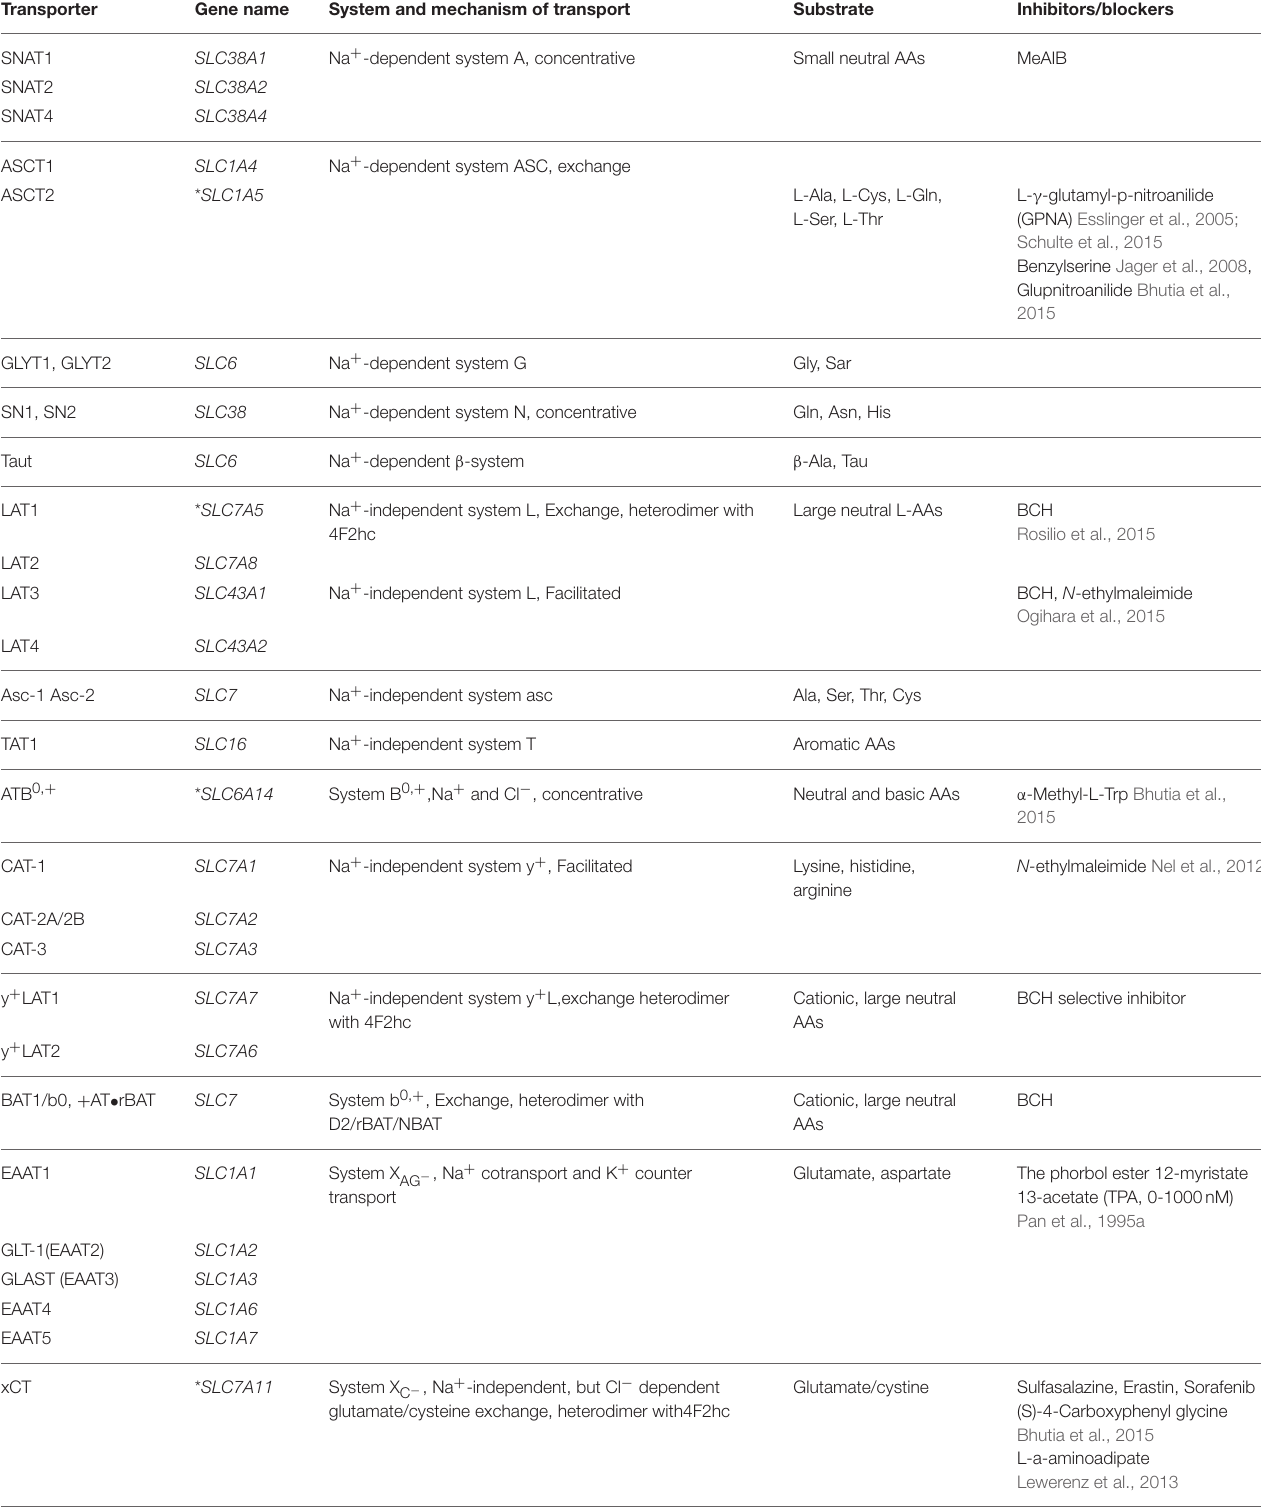
* Low-level expression in normal tissues, but up-regulated expression in many human tumors. AAs, amino acids; MeAIB, N-methyl aminoisobutyric acid; BCH, 2-amino-endo-bicyclo[2,2,1]heptane-2-carboxylic acid.